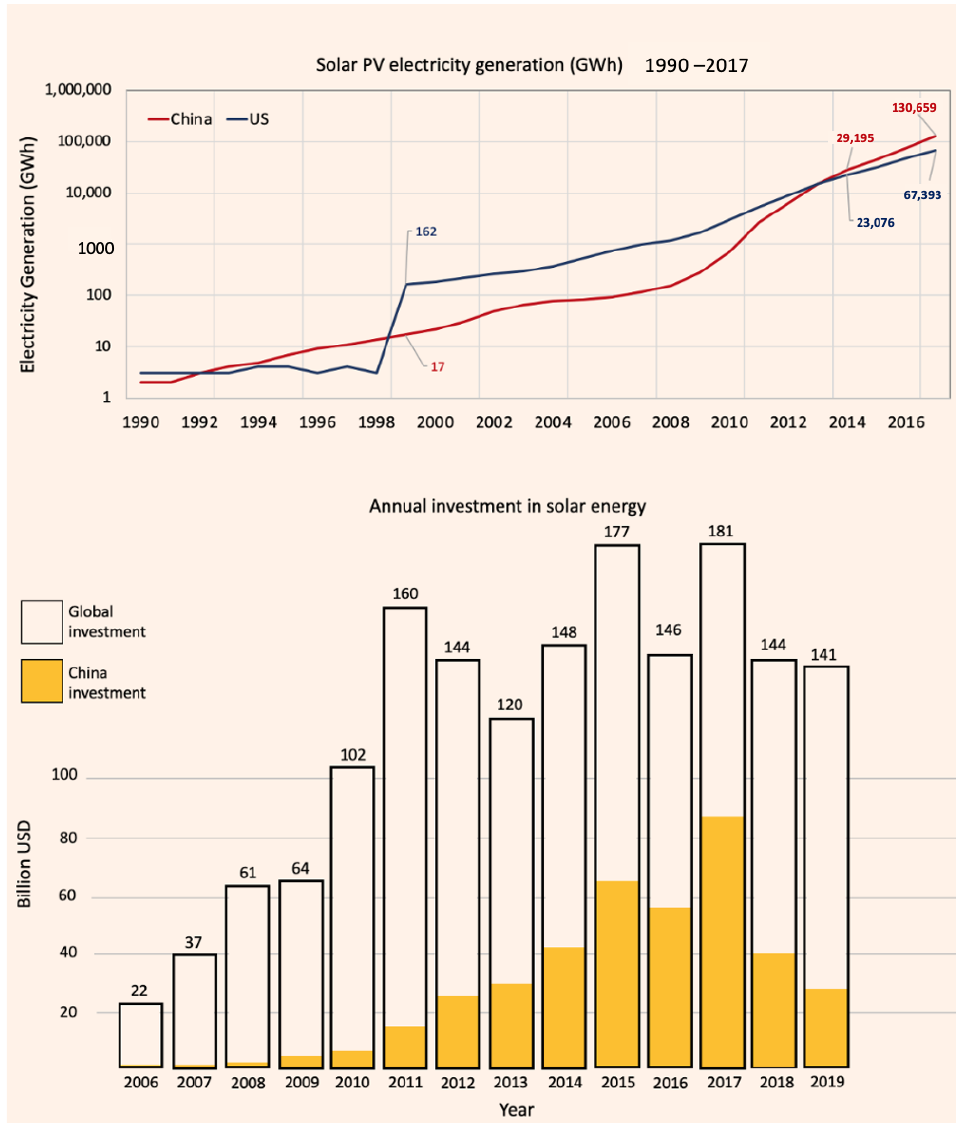
Figure 3. Solar energy electricity generation (GWh) for China and the US between 1990 and 2017. In this graph, the electricity generation axis has a logarithmic scale. A comparison between the global